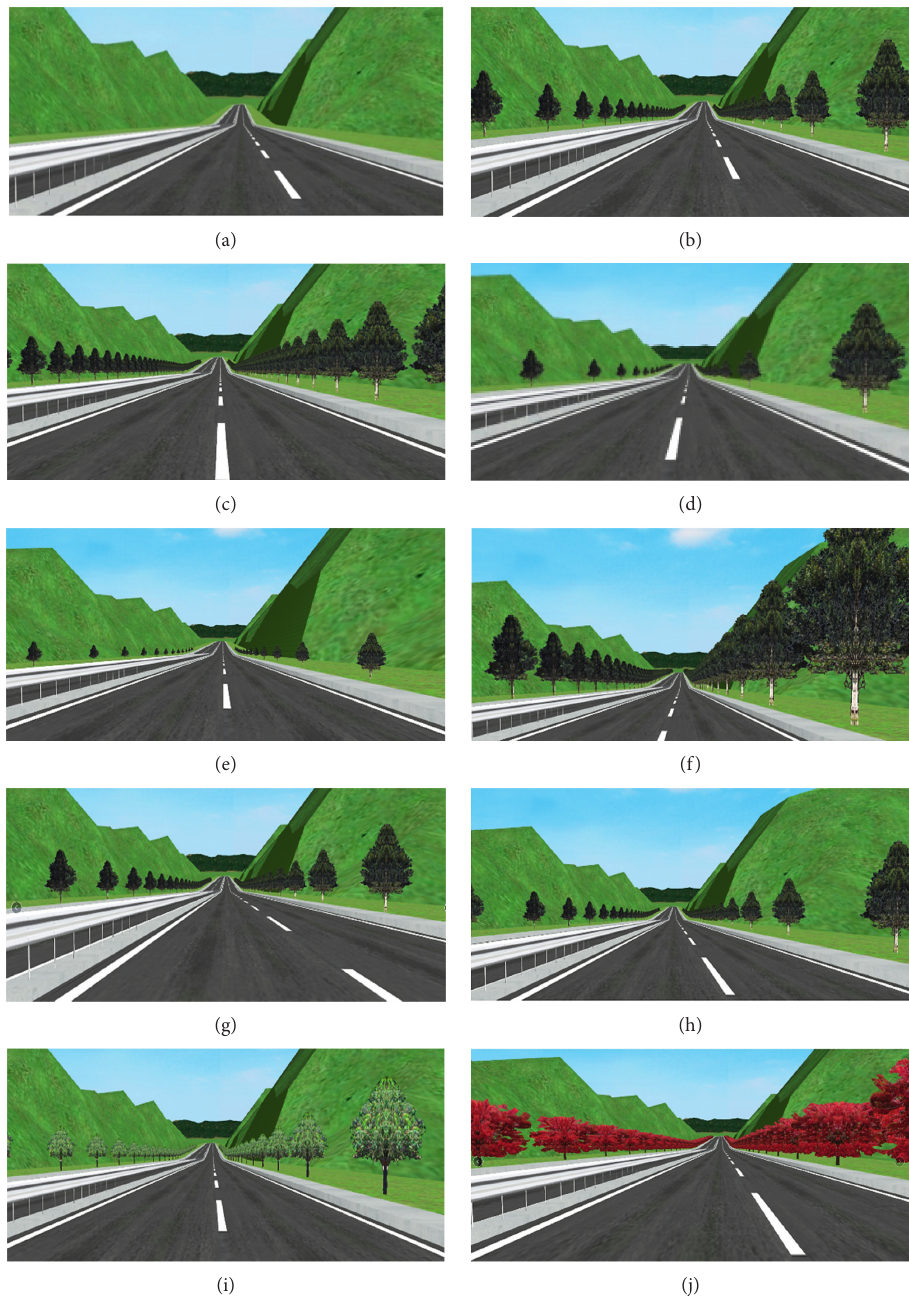
Figure 2: Scene map corresponding to each landscape factor. (a) Not processed. (b) Reference road section scene. (c) Plant spacing factor level. (d) Plant spacing factor level 3. (e) Height factor level 2. (f) Height factor level 3. (g) Roadside distance factor level 2. (h) Roadside distance factor level 3. (i) Color factor level 2. (j) Color factor level